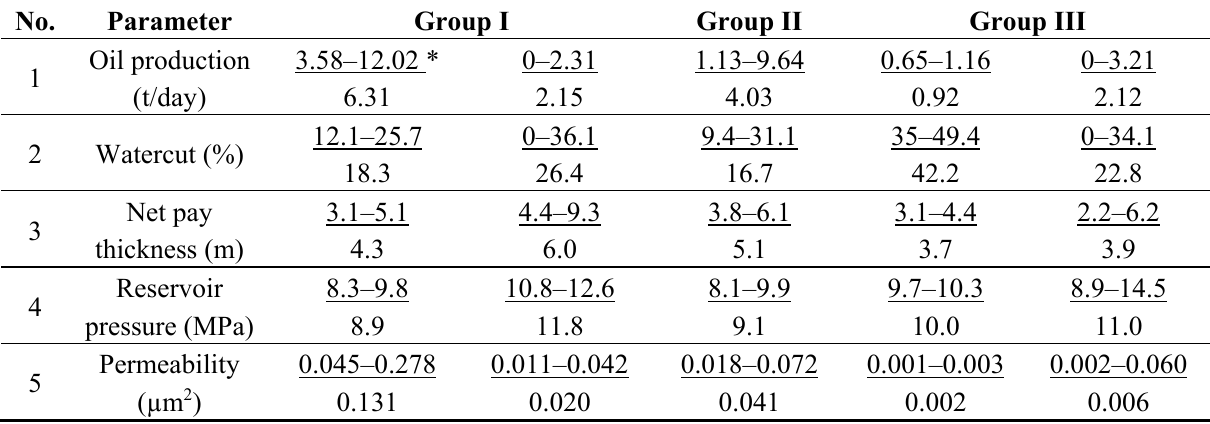
Table 3. Allocated parameters of the wells to assess the effectiveness of enhanced oil recovery